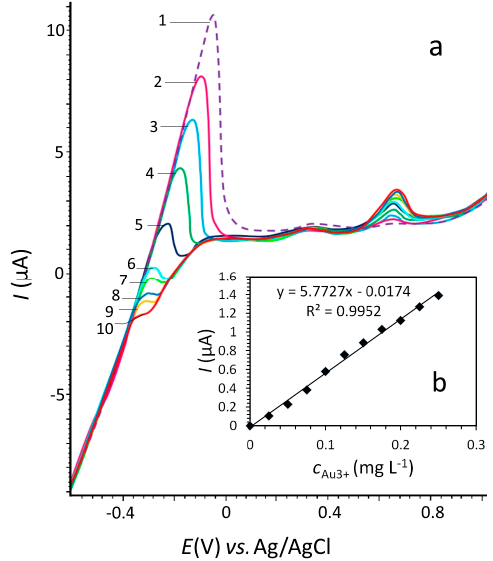
Figure 8. Anodic current–voltage curves (a) and calibration dependences during electrooxidation of gold deposits from the surface of a GE modified by bismuth (b) . Experimental conditions: medium of 1 mol L − 1 HCl, E e = − 0.7 V, t e = 120 s, v = 0.06 tV s − 1 , с Bi3+ = 10 mg L − 1 ; c Au3+ (mg L − 1 ): (1) 0, (2) 0.025, (3) 0.05, (4) 0.075, (5) 0.1, (6) 0.125, (7) 0.15, (8) 0.175, (9) 0.2, and (10) 0.225.